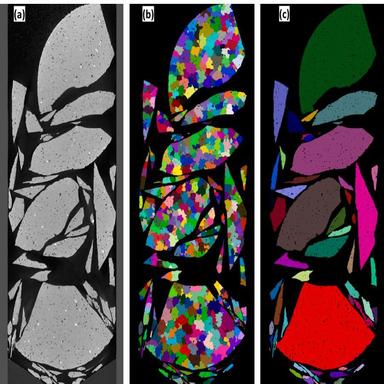
Vertical slices from 3D images of the quartz particles: (a) raw tomogram, note the dark speckles which are internal pores; (b) particle separation result from a watershed-based method only; (c) particle separation result after the new method illustrated in 2.